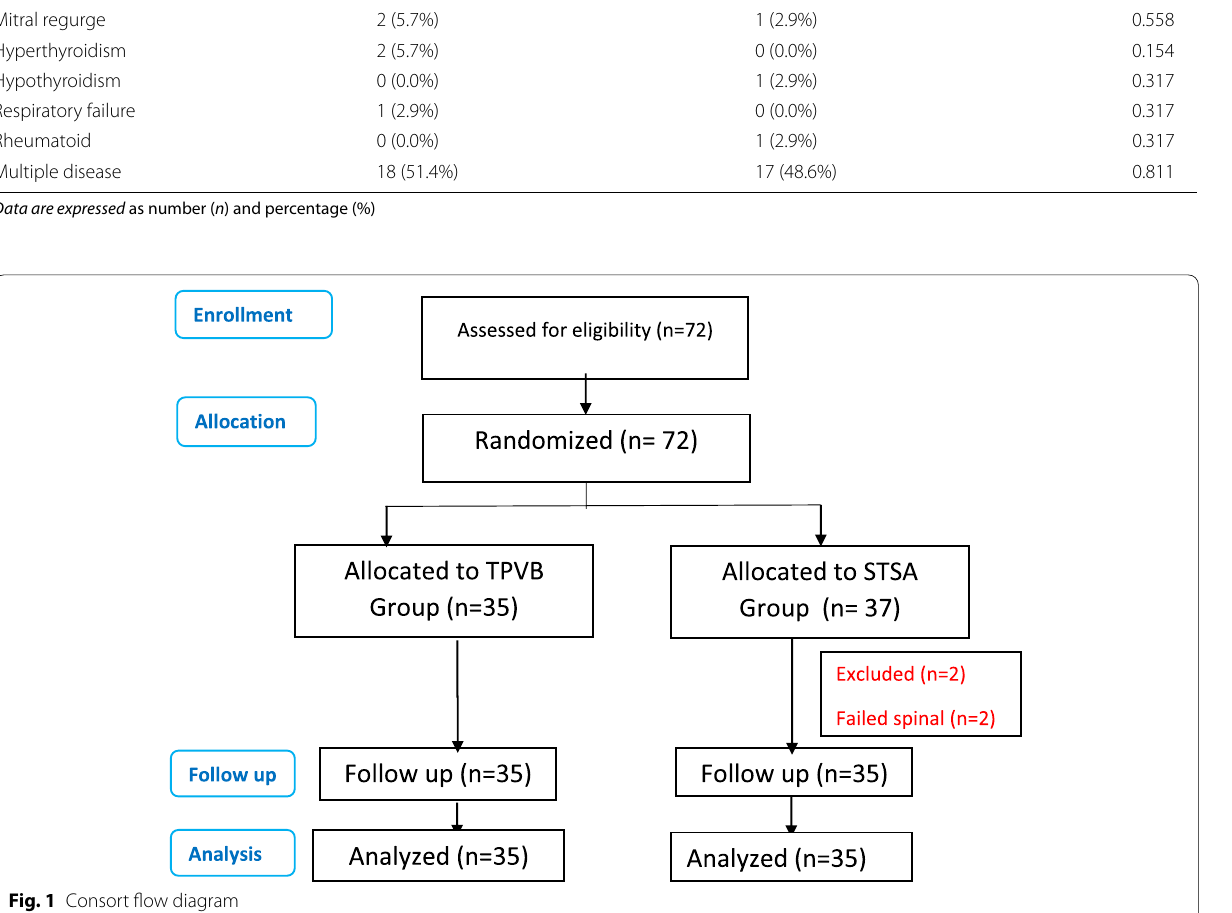
Table 3 Sensory block data